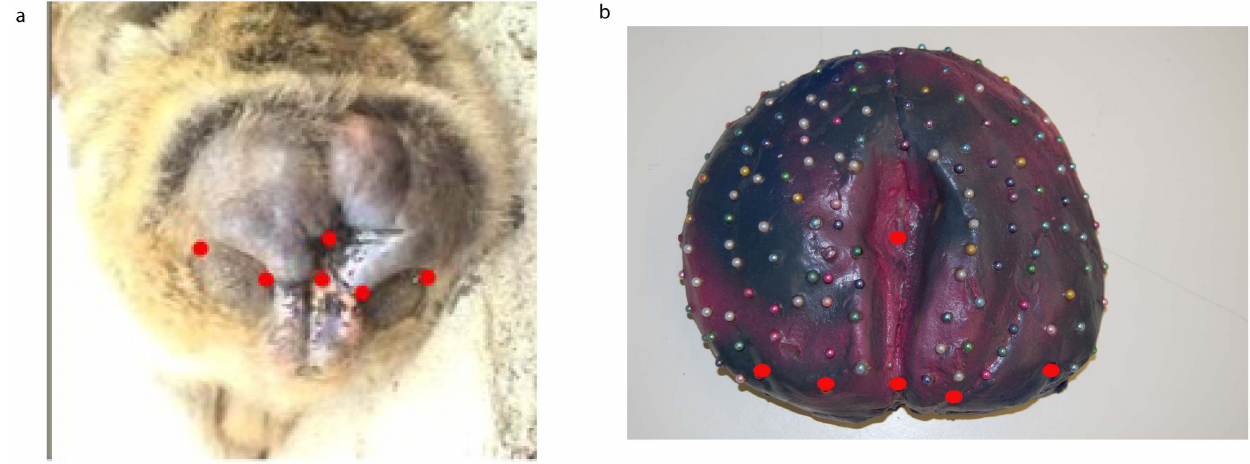
Figure 2. Homologous points on a real macaque swelling and on an artificial swelling. The artificial swellings were manufactured in a way that they mimic the nature of real ones. The six homologous points are indicated by red